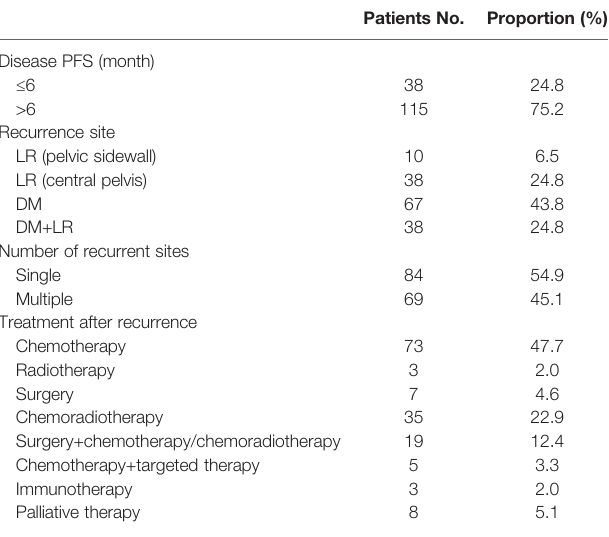
TABLE 2 | Recurrence patterns and treatment mode of recurrent cervical cancer patients.